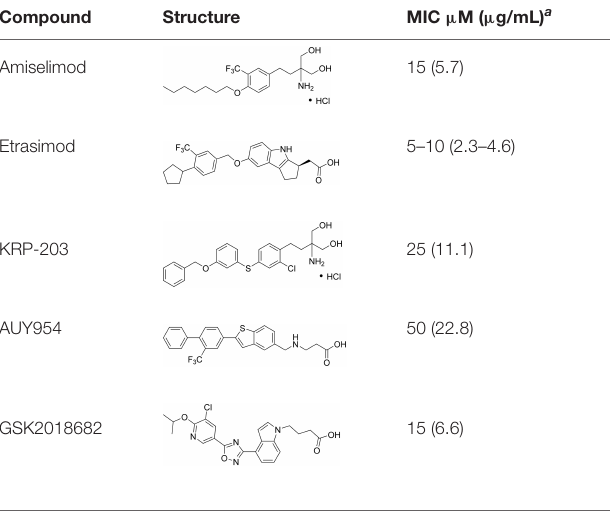
TABLE 1 | Antibacterial activity of the five active sphingosine-1-phosphate receptor (S1PR) modulators against Staphylococcus aureus ATCC 25923.